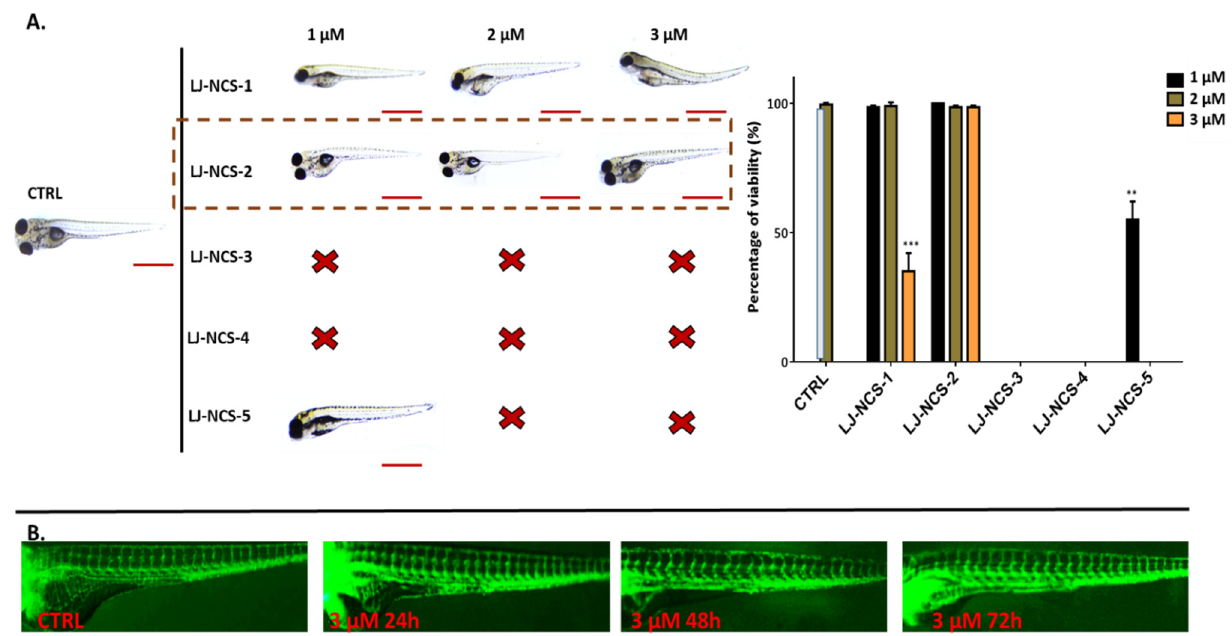
Figure 10. The effects of 72 h isothiocyanates treatment on morphology and mortality of 48 hpf zebrafish embryos at the experiment starting point. LJ-LNC-2 no effect on vascularization of zebrafish embryos. ( A ) Representative images of embryos exposed by 1–3, of LJ-NCS-1–5 (n = 3 replicates, 50 embryos per replicate); bar scale = 950 µm. Percentage of viability-data are represented as mean ± SD; ** p < 0.01, *** p < 0.001. ( B ) Representative picture (taken under fluorescence microscope) of blood vessels (green) of Tg(fli1:EGFP)y1 strain (48 hpf zebrafish embryos at the starting point) upon 3 µM LJ-NCS-2 treatment in 24, 48 and 72 h time points.